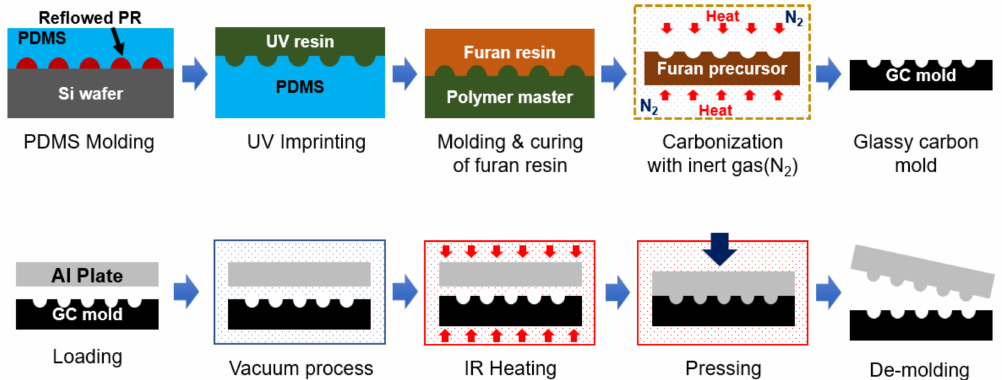
Figure 1. Schematic of a fabrication process for the glassy carbon (GC) mold and the direct metal forming (DMF)